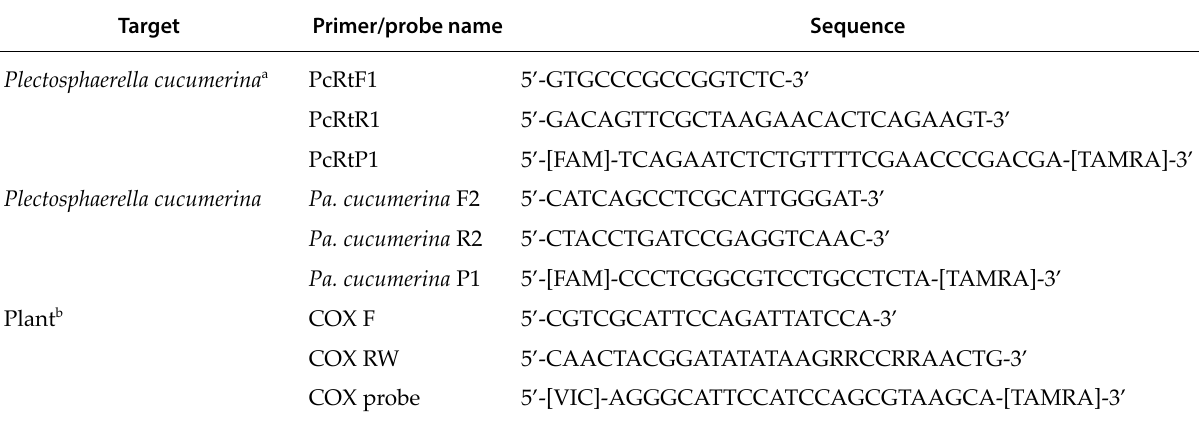
Table 2. Sequences of real-time PCR primers and probes used in this